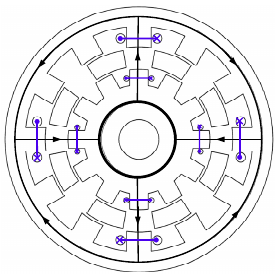
Figure 7. Magnetic flux of the single phase of DSSRM to unaligned with the excited stator pole.